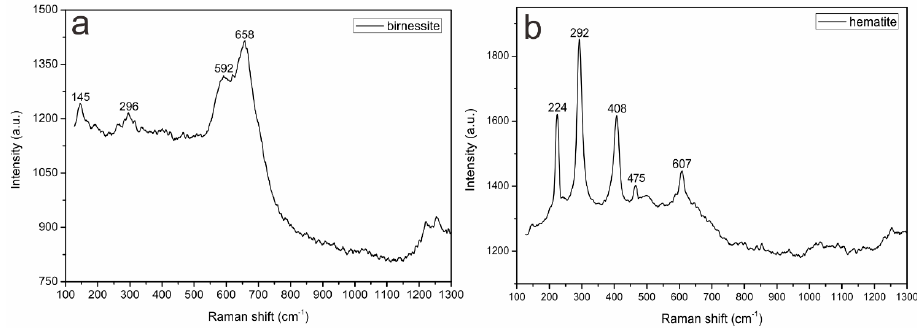
Figure 9. Raman spectra of the rock Fe / Mn coating. ( a ) Birnessite; ( b ) hematite.